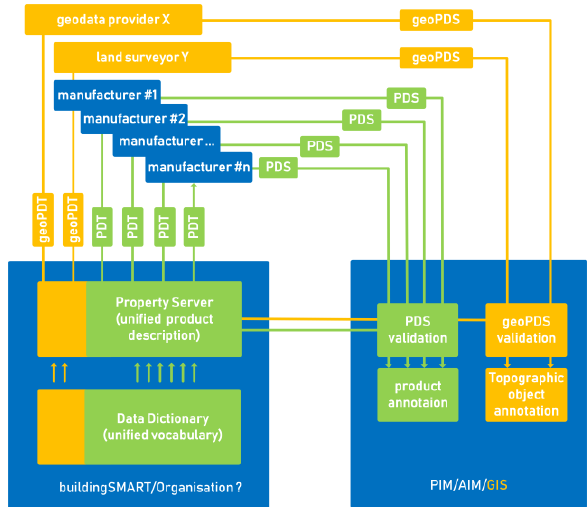
Figure 6 Product Data Sheets (PDT) for uniform description of construction products (green) and geodetic products (orange)